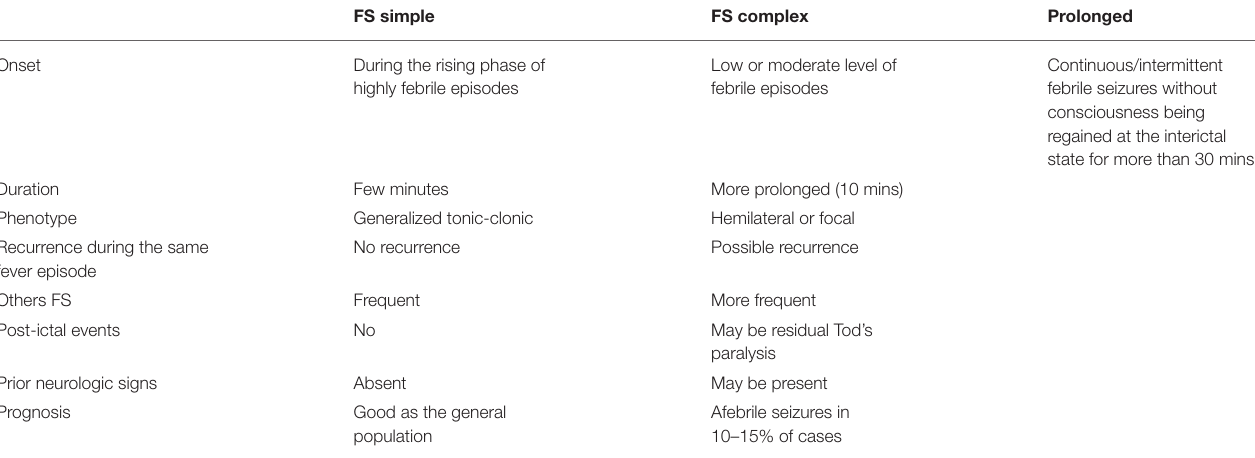
TABLE 1 | Differences between simple (typical), complex (atypical), and prolonged febrile